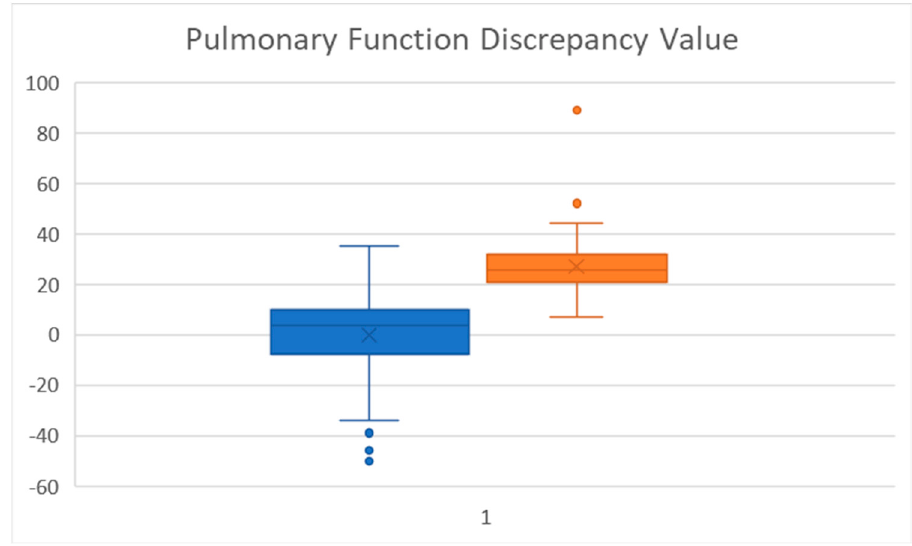
Figure 2. Difference between % predicted FEV 1 % Predicted FEF 25-75 (Blue, No SAD, Orange, SAD).